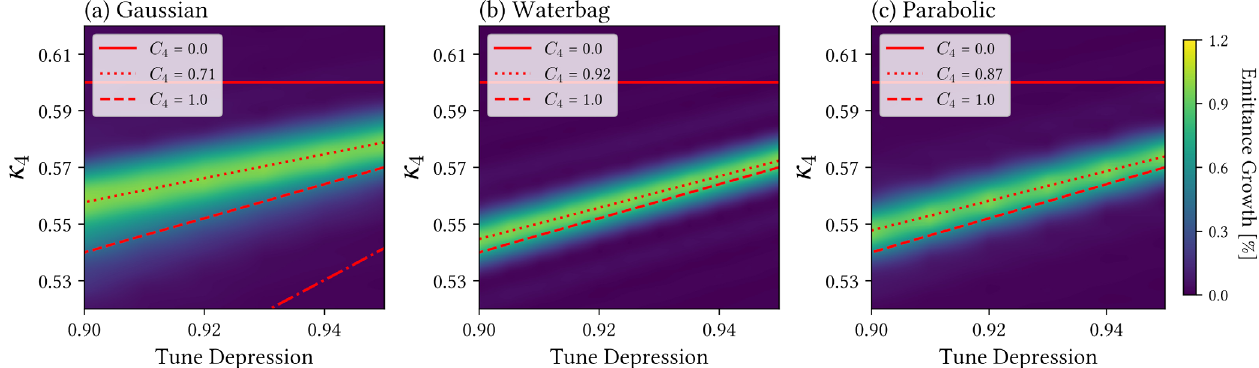
FIG. 14. Emittance-growth chart obtained from W ARP simulations with the octupole driving perturbation on. Except for the order of the external perturbing field, all numerical conditions are the same as employed in Fig. 12. The perturbation amplitude is set at 0.6% of the focusing field ’ s. The dotted line is the location of the stop-band peak fitted by Eq. (14) with C 4 ¼ 0 . 71 for Gaussian, C 4 ¼ 0 . 92 for waterbag, and C 4 ¼ 0 . 87 for